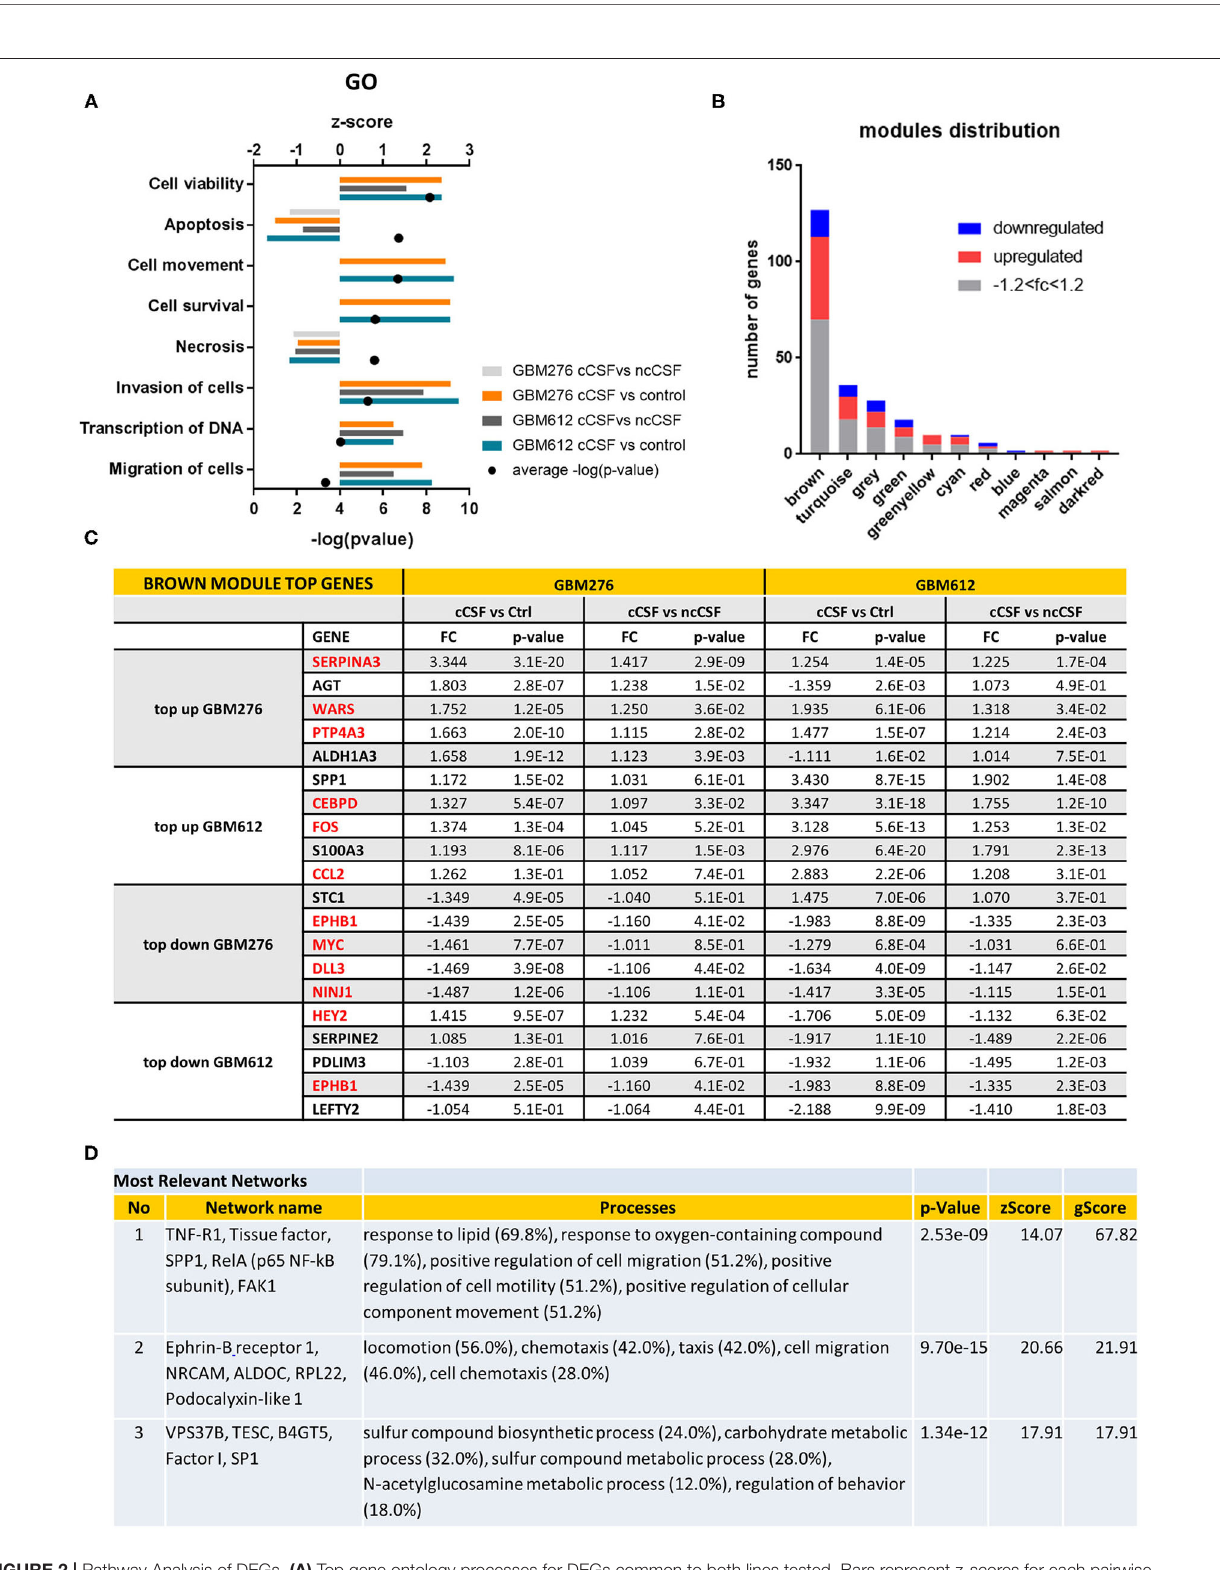
FIGURE 2 | Pathway Analysis of DEGs. (A) Top gene ontology processes for DEGs common to both lines tested. Bars represent z-scores for each pairwise comparison, dots represent –log( p -value) averages of the 4 pairwise comparisons. (B) Distribution of DEGS in WGCNA modules, with the brown module containing most of the significant DEGs defined by p -value < 0.05. Red indicates upregulation of fold change + 1.2, blue indicates downregulation of fold change − 1.2. (C) Top 5 up or down-regulated DEGs in brown module for GBM276 and GBM612 with relative fold change (FC) and p -value in each pairwise comparison. Common DEGs are represented in red. (D) Most relevant networks for common DEGs in the brown module using Metacore algorithm Analyze Networks. FC, fold change; FDR, false discovery rate.